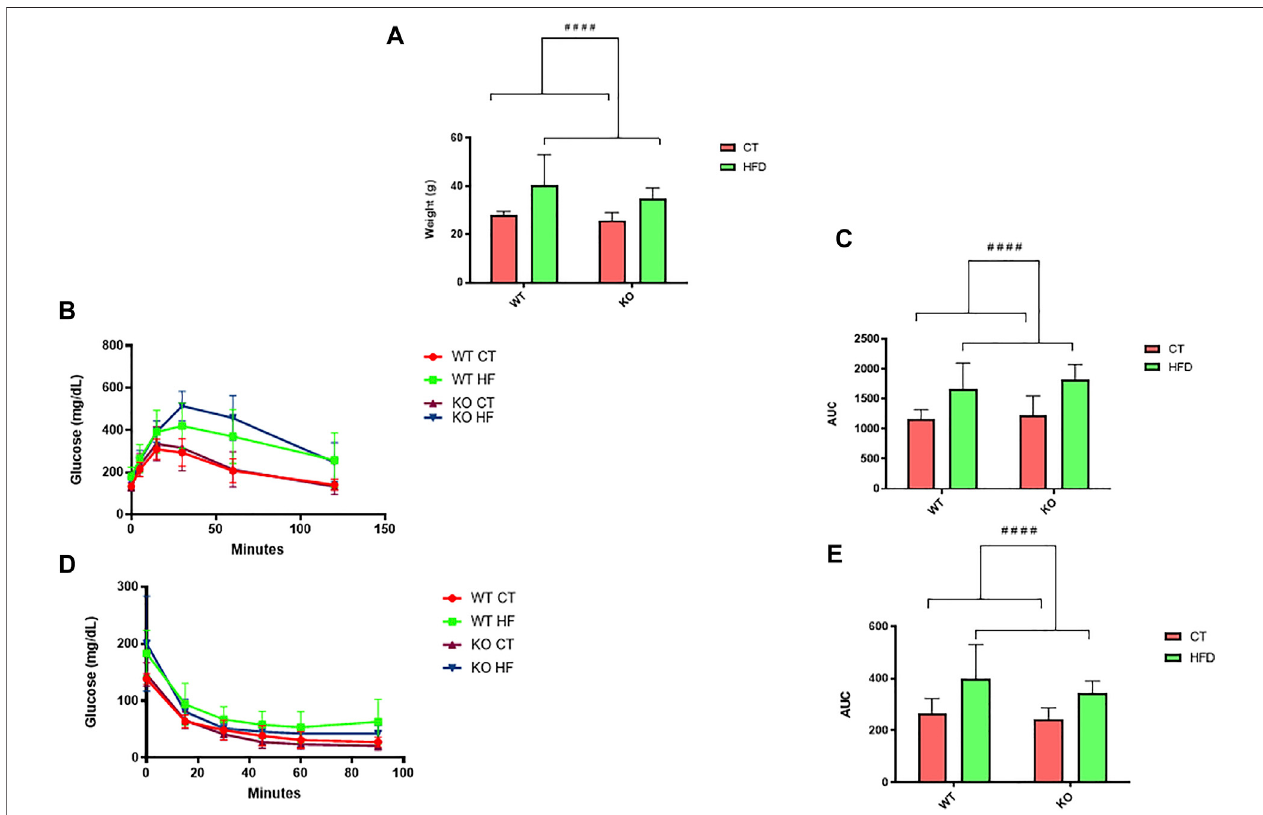
FIGURE 1 | (A) Analysis and representation of changes in body weight ( n = 12 animals per group). (B) GTT and (D) ITT experiment pro fi les ( n = 12 animals per group).Areaundercurve(AUC)datawerecalculatedfromthetimepoint0untiltheendoftheexperimentforboth (C) GTTand (E) ITT.Statisticalanalysiswasperformed through two-way ANOVA. Signi fi cant differences were found between control and high-fat diet groups: #### denote p < 0.0001.